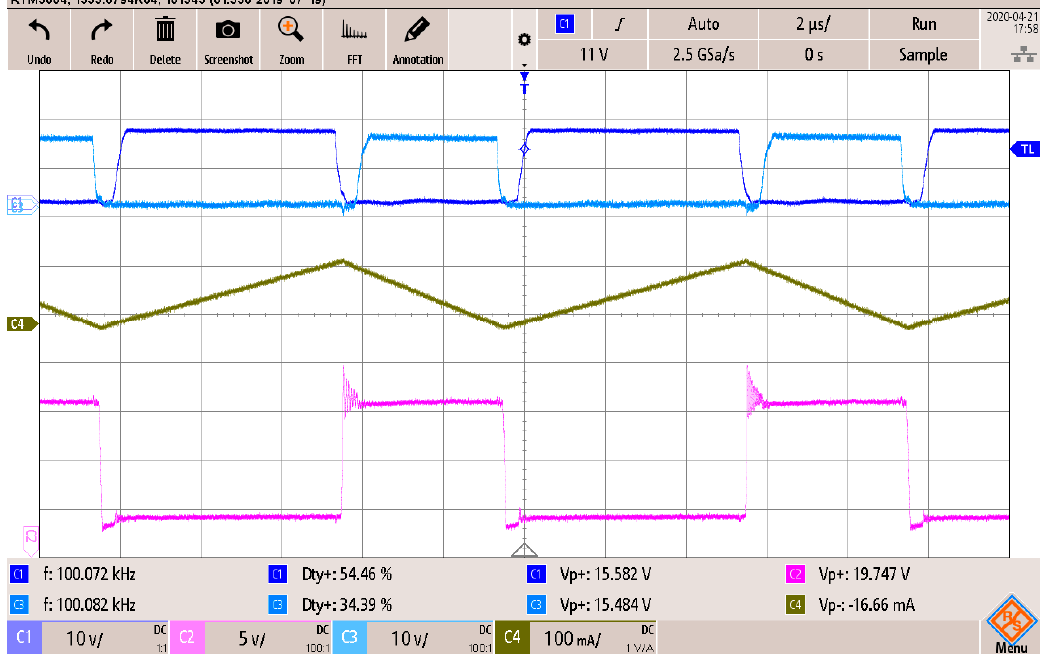
Figure 20. Waveforms of switch V GS , V DS and inductor current with 10 V of input and 12 V/1 A of output (CH1, V GS 1 ; CH2, V DS 1 ; CH3, V GS 1 ; CH4, I L ).